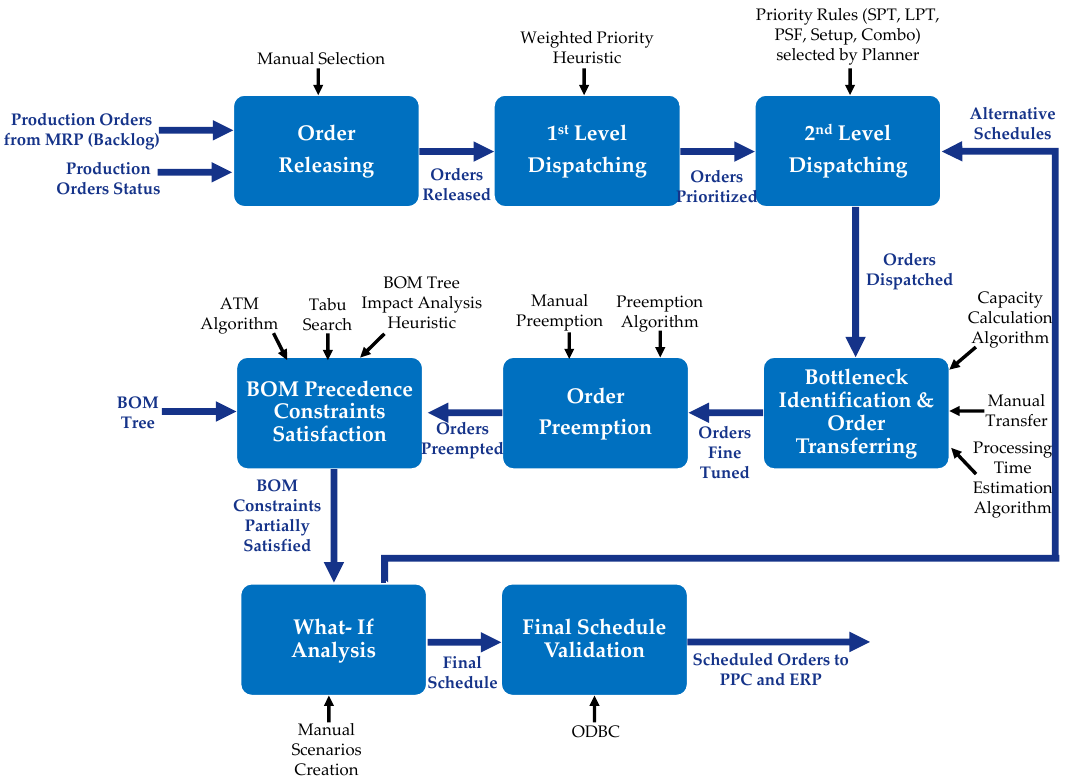
Figure 1. Scheduling process and functionality of the decision support system.